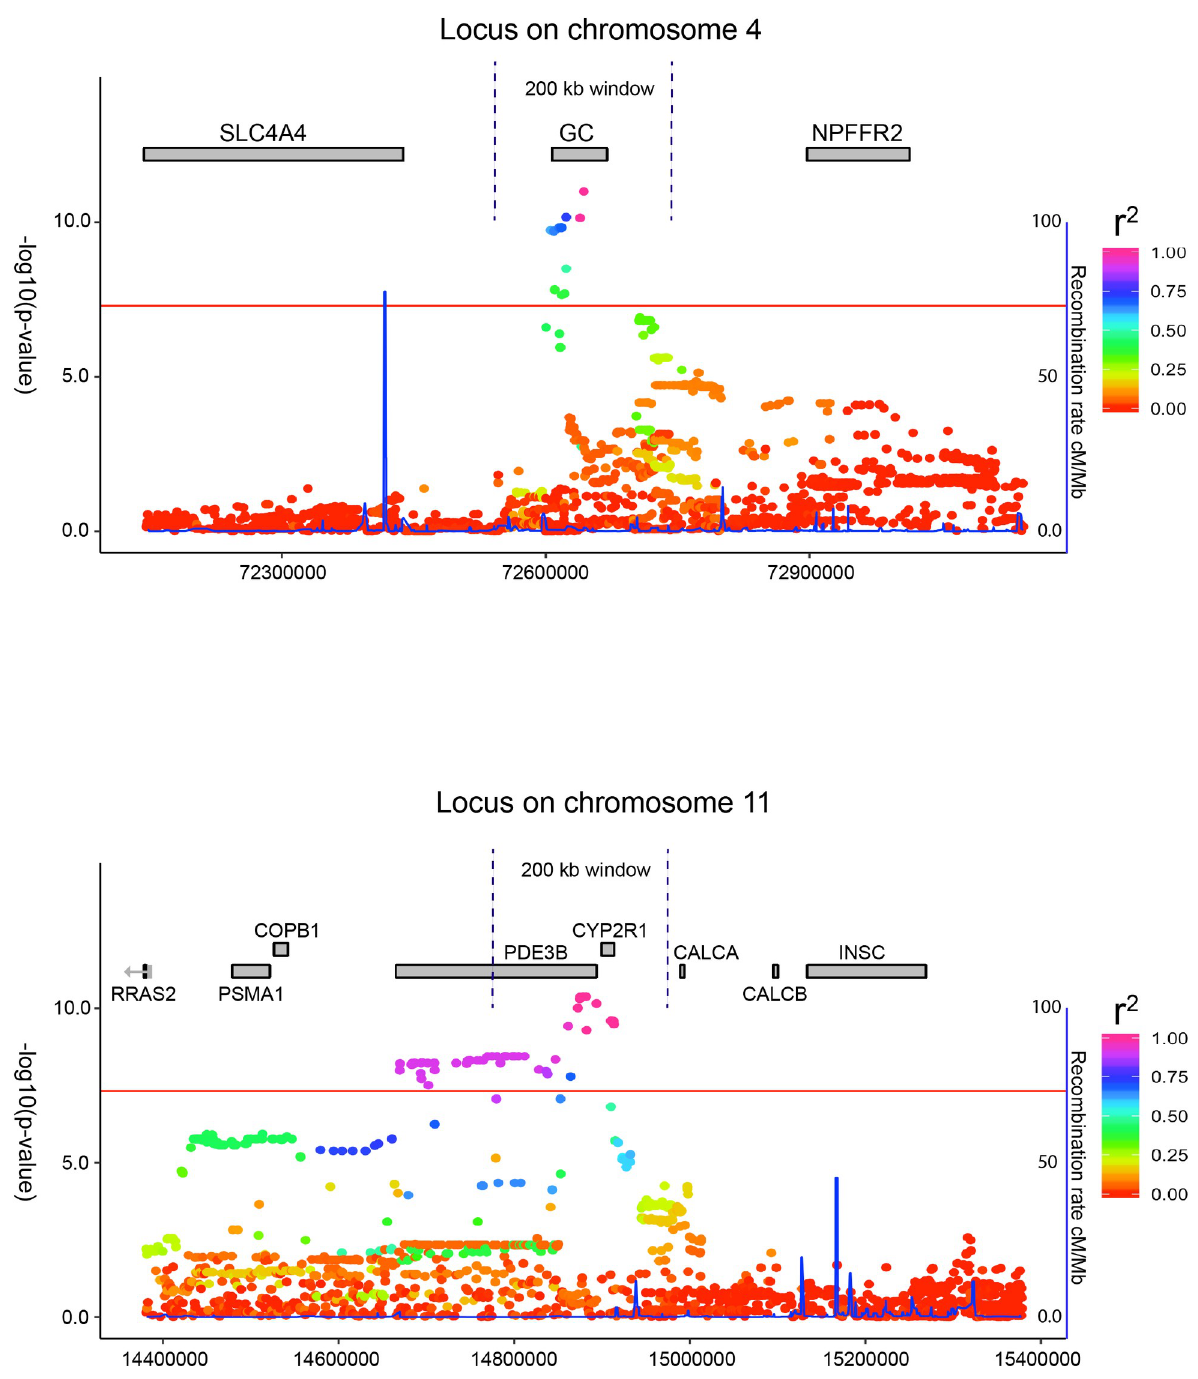
Fig 4. The two loci and their nearby genomic regions. A close up view of the genomic regions immediately surrounding the lead SNPs in each locus. The gene GC is the only gene within the 200 kb target window on chromosome 4, making it the likely candidate for the signal. For the locus on chromosome 11, both PDE3B and CYP2R1 are located within the window for likely candidates as the underlying cause of the